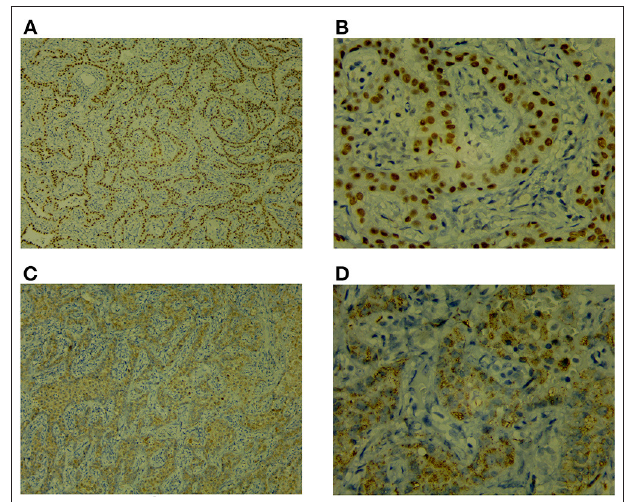
FIGURE 2 | The pathological images of two GGOs show that the heteromorphic cells are arranged in the form of acini, the cells are dense, the nucleus is hyperchromatic, the cytoplasm is abundant and eosinophilic, peripheral fibrous tissue and lymphocyte proliferate. (A) Lesions in the posterior segment of the left upper lobe apex, HE × 200. (B) Lesions in the posterior segment of the left upper lobe apex, HE × 400. (C) Lesions in anterior basal segment of right lower lobe, HE × 200. (D) Lesions in anterior basal segment of right lower lobe, HE × 400.